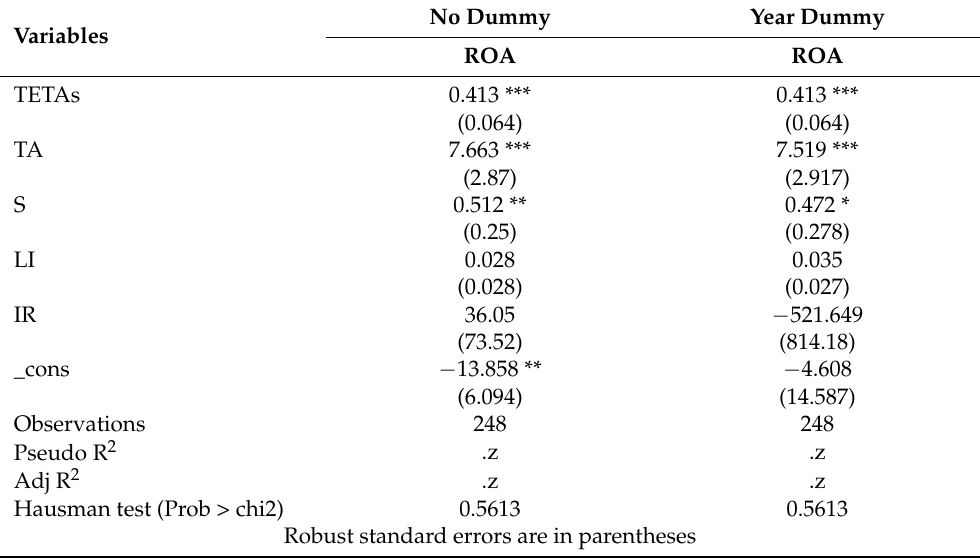
Table 16. Results of the Random Effects of TETAs on ROA, as per Panel Data Regression (Loss-making